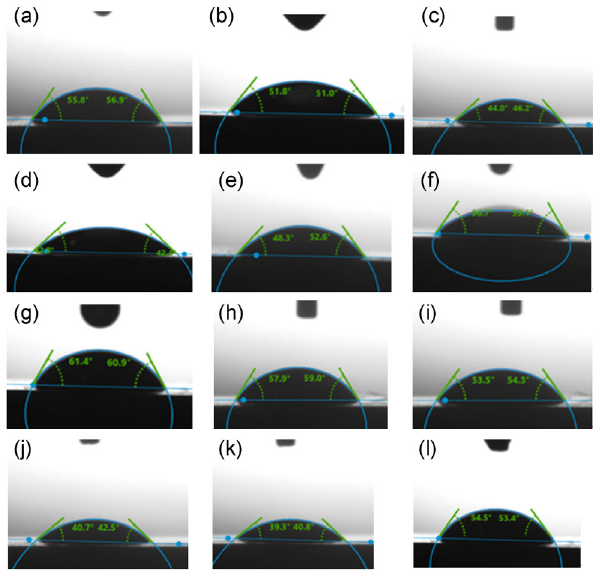
Fig. 6 Examples of drop pendants on carbide tool surface for Alumina nanofluid (a) 0.25 vol%, (b) 0.5 vol%, (c) 0.75 vol%,